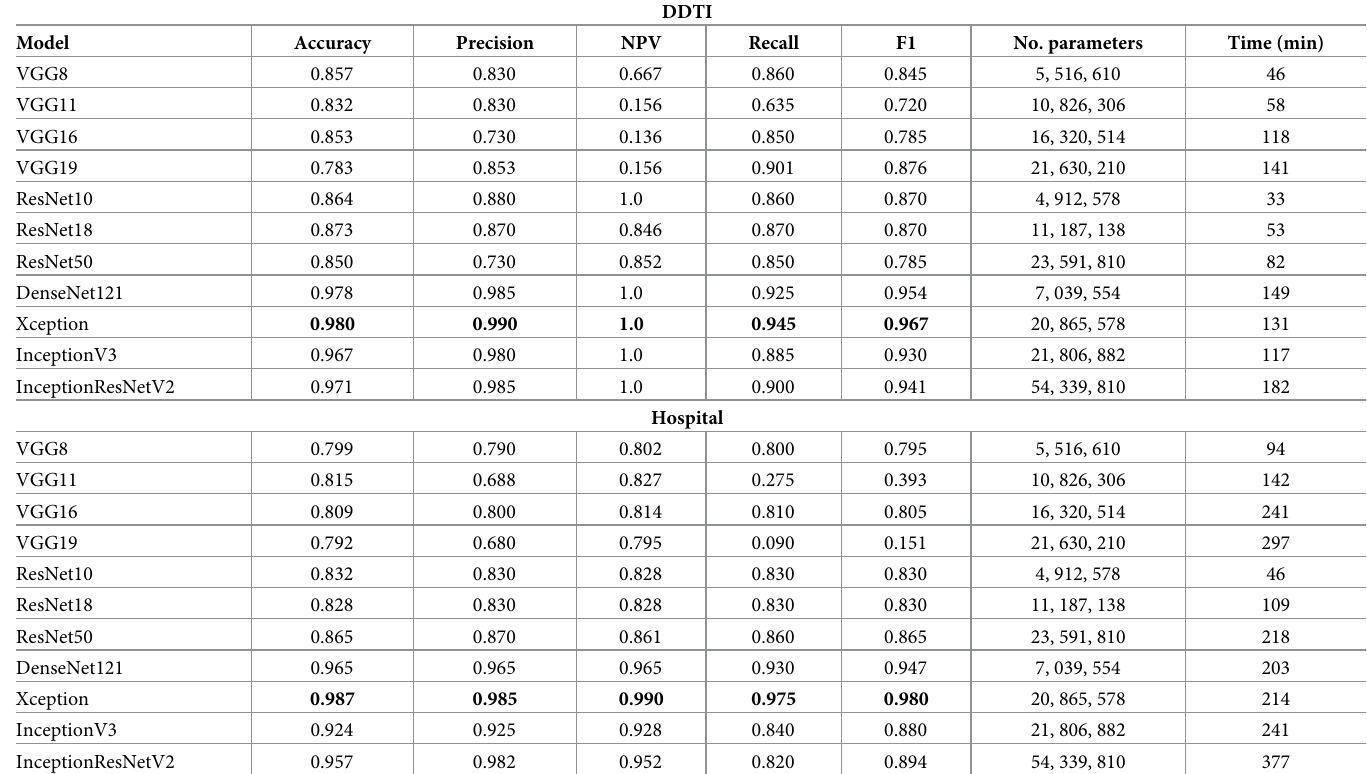
Table 2. Comparison of various CNN models in binary classification tasks: Different sources of ultrasound images were applied for thyroid cancer detection.